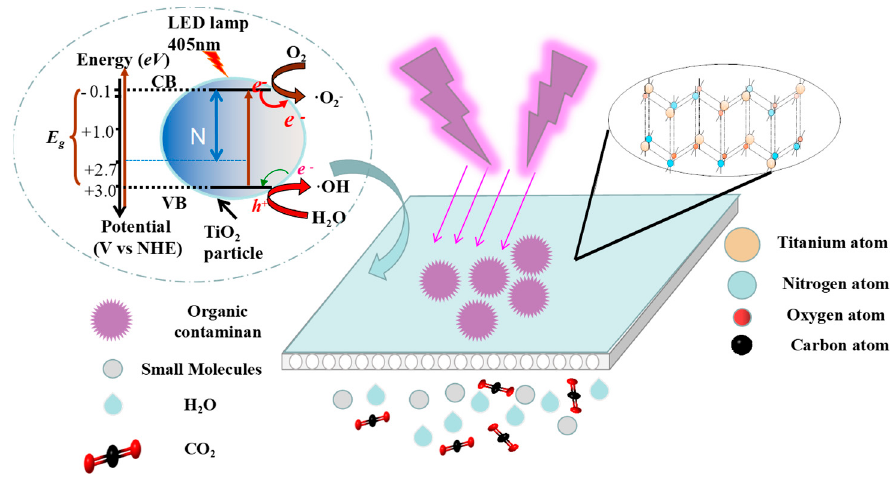
Figure 9. Diagram of reaction mechanism of MP purification by N-TiO 2 -CM.